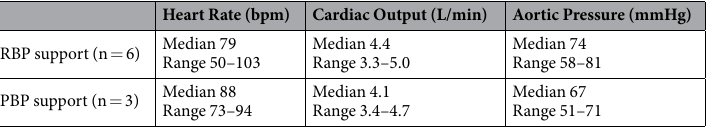
Table 1. Median and range of baseline hemodynamic parameters of the experiments with RBP and PBP support, n indicates the number of experiments. RBP – rotary blood pump; PBP – pulsatile blood